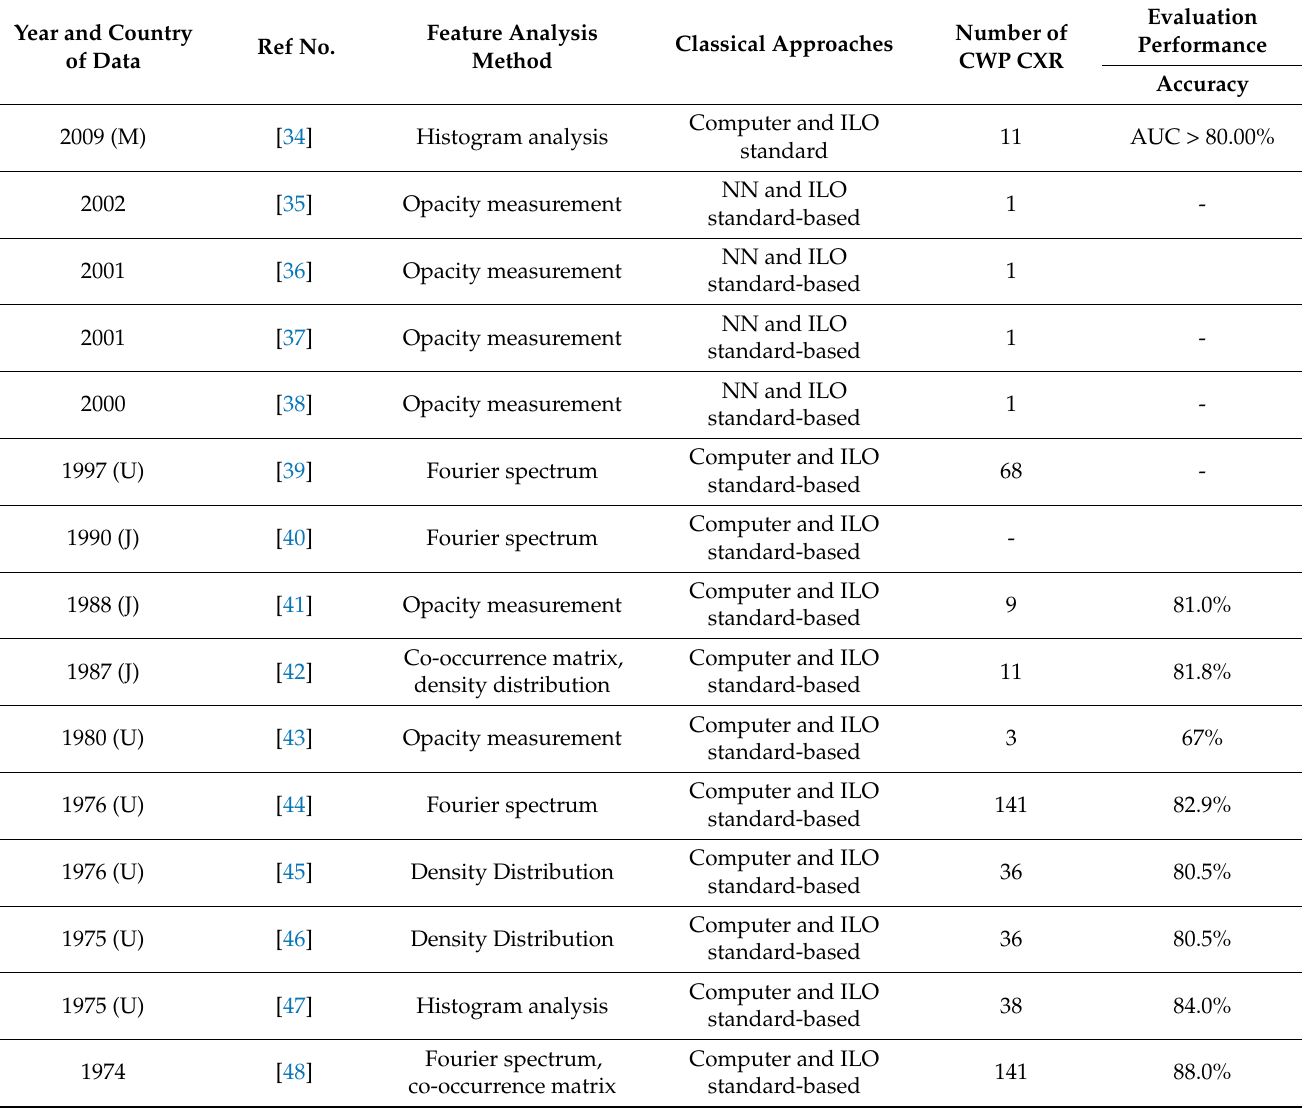
Table 2. Summary of classical approaches included